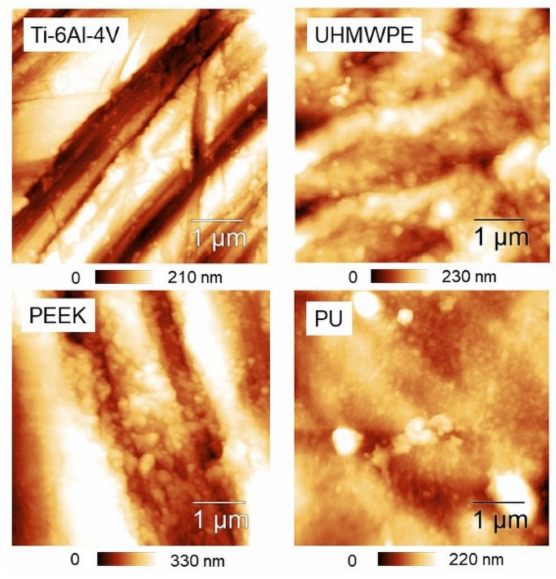
Figure 6. 5 × 5 µ m 2 AFM topographies of the four surfaces.